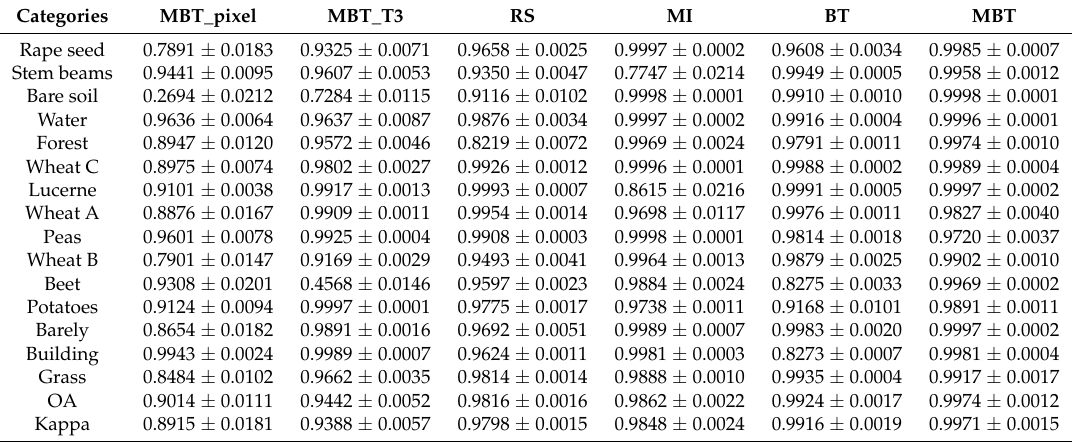
Table 2. The classification results obtained for the AIRSAR imagery with different strategies.